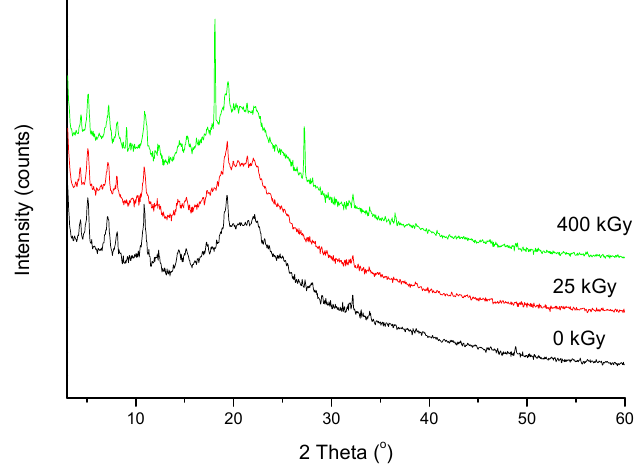
Figure 5. Differential scanning calorimetry (DSC) curves of non-irradiated and irradiated (25 and 400 kGy) ERP.